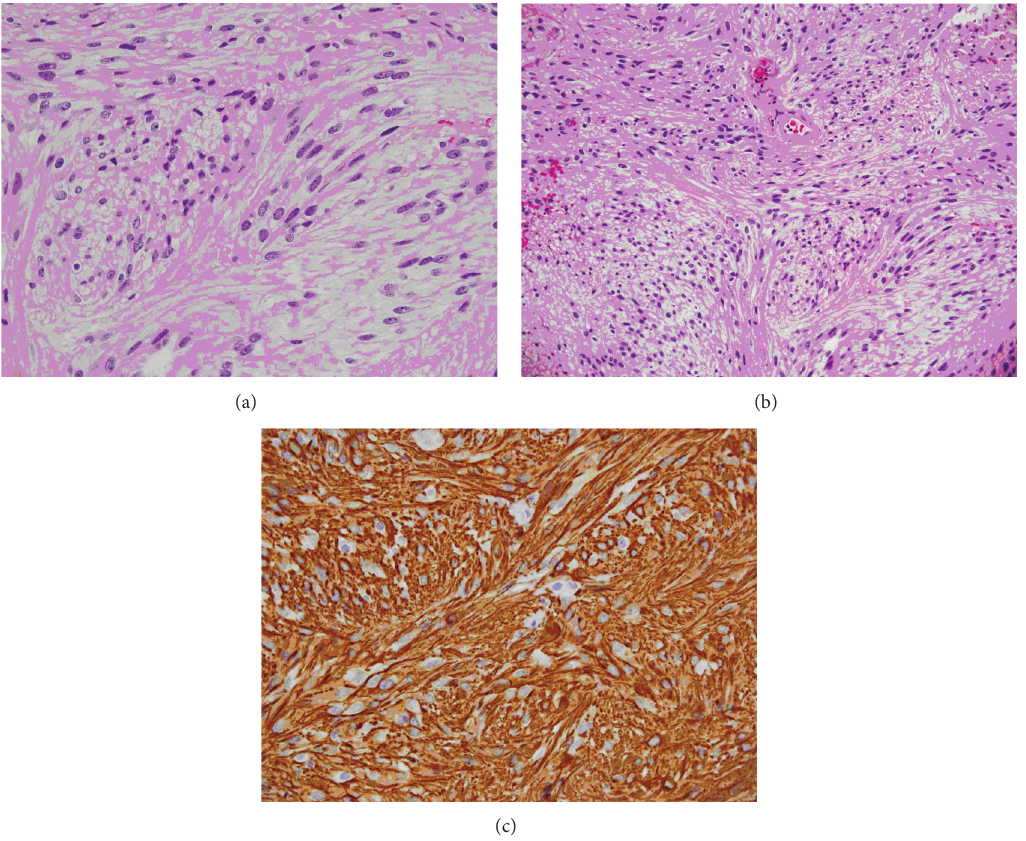
Figure 3: (a) Histological section showing spindle cell neoplasm of moderate cellularity arranged in interlacing fascicles. Hyalinized blood vessels and foci of hemosiderin pigment deposits are present. (b) Histological section showing neoplastic cells with oval to elongated nuclei with speckled chromatin and small nucleoli. (c) Histological section demonstrating cells that stained strongly positive for